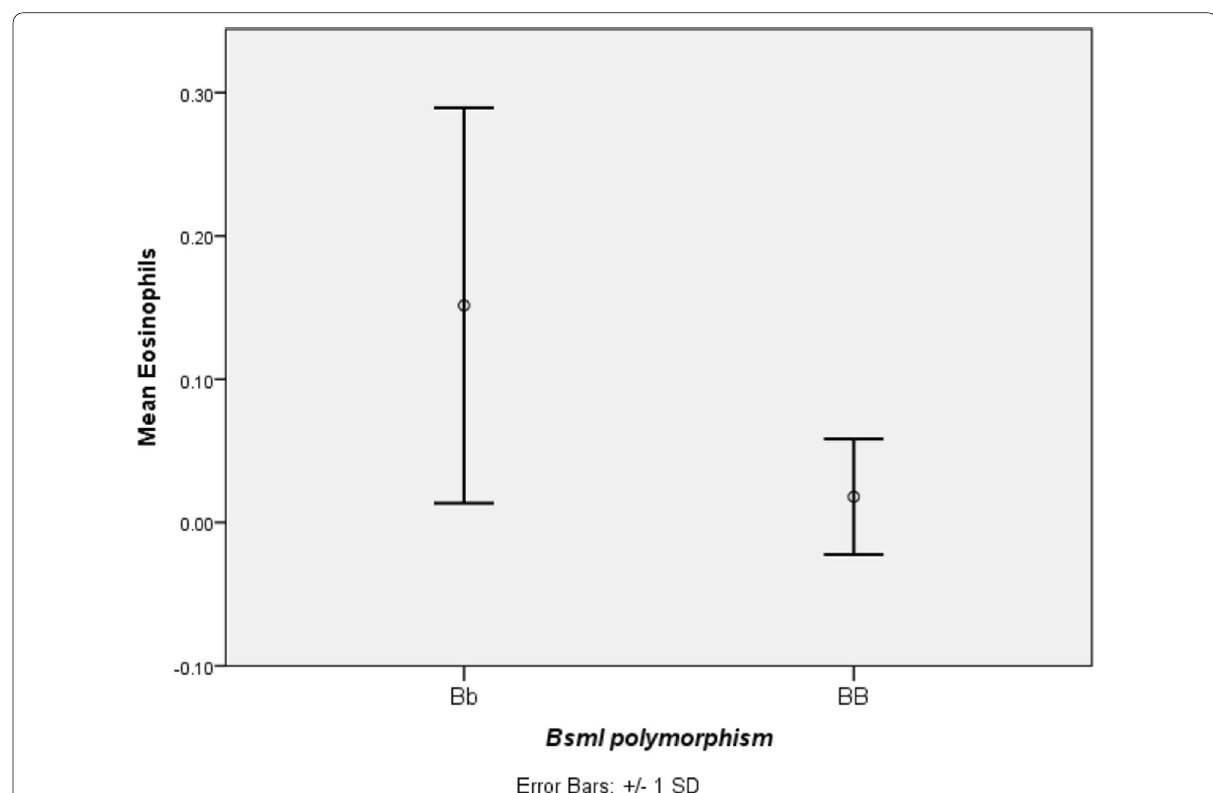
Fig. 4 Relation between BsmI polymorphism and